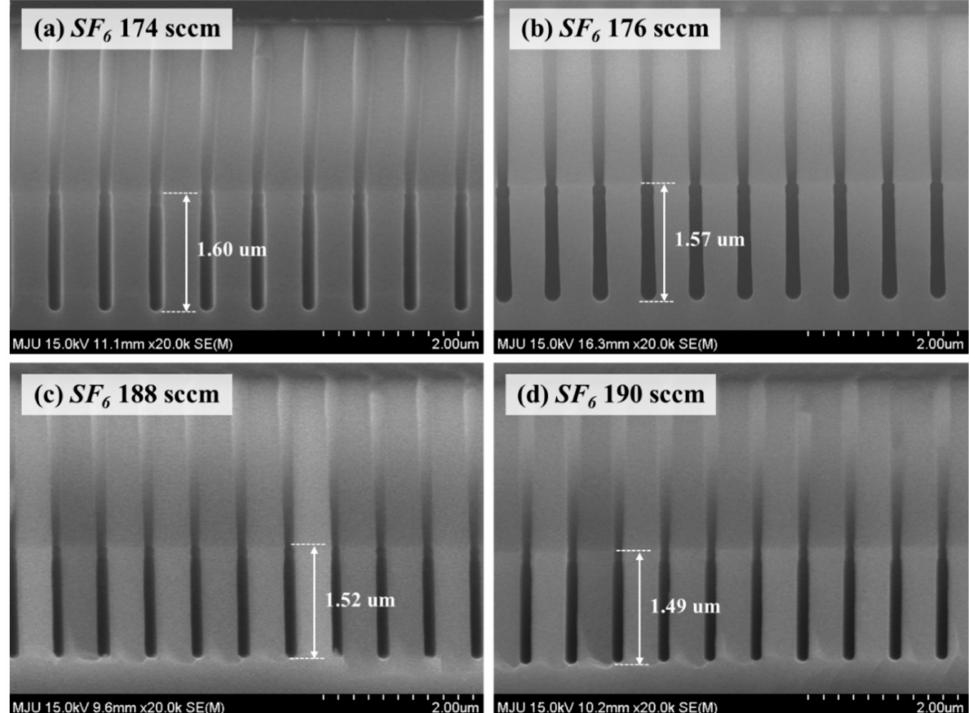
Figure 5. Cross-sectional scanning electron microscope (SEM) image. ( a ) Silicon etch profile with 174 sccm of SF 6 gas flow, ( b ) Silicon etch profile with 176 sccm of SF 6 , ( c ) Silicon etch profile with 188 sccm of SF 6 gas flow, and ( d ) Silicon etch profile with 190 sccm of SF 6 gas flow. The increment of gas flow showed decreased silicon etch depth and ( b ) showed the most undesired etch profile with lateral sidewall etch.